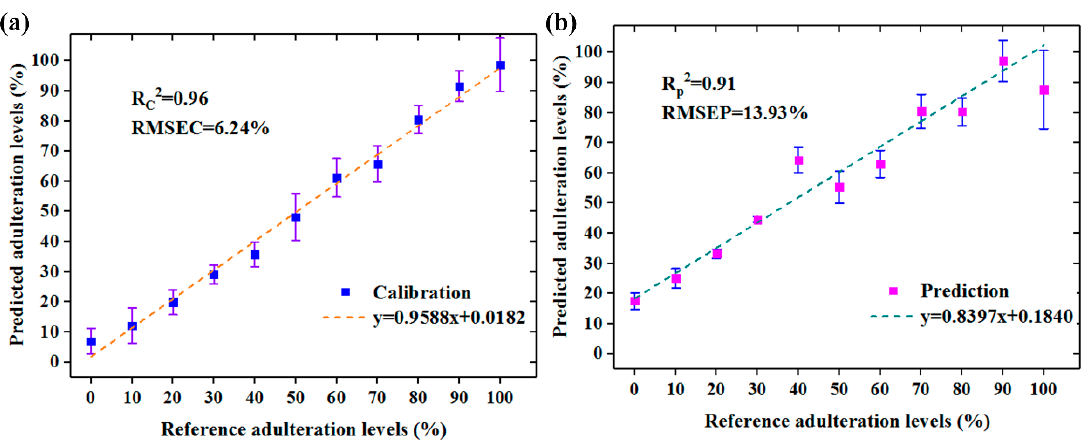
Figure 5. The performance of preferred multispectral RC-PLSR model with error bar in ( a ) Calibration set, and ( b ) Prediction set.